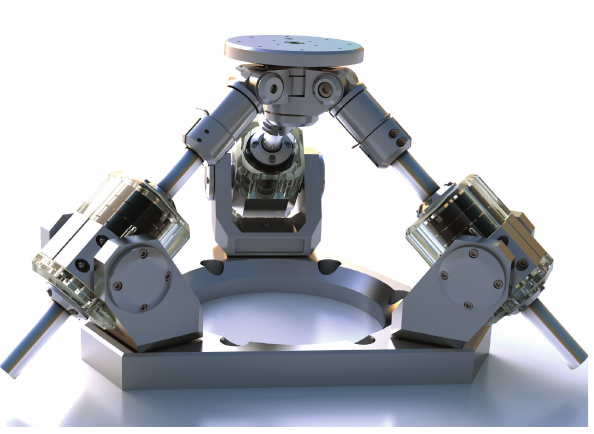
Figure 2: Novel 5-DOF spatial parallel micromanipulator. axis of rotation coinciding with the main axis of the